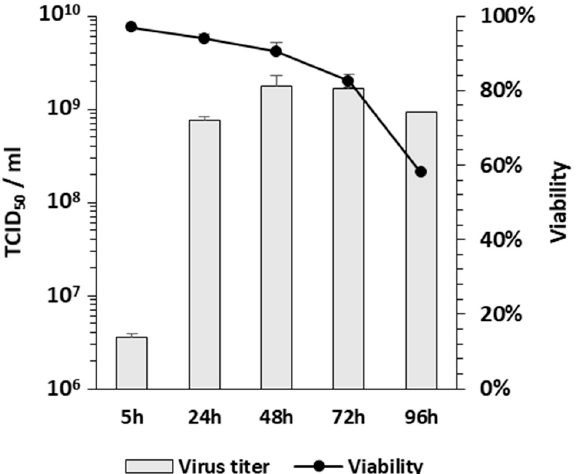
Figure 5. Virus growth curve of AdPS- in the SF-BMAdR- λ R-GyrB-PS-174-12A subclone. Two 125 mL shaker flasks of cells at 25 mL of working volume were infected with a MOI of 5 TCID 50 in the presence of 5 nM of coumermycin ( n = 3). The cell viability was recorded at each time point and the virus progeny was measured by a TCID 50 assay in duplicate, expressed as TCID 50 /mL, and shown as mean ± SEM.